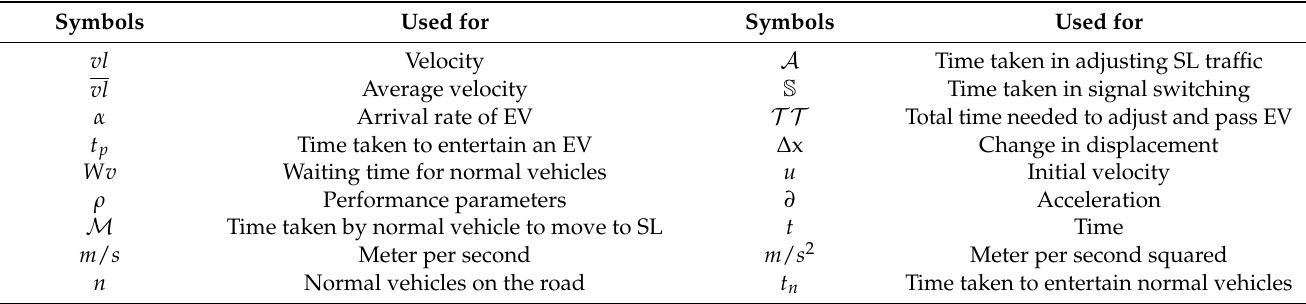
Table 3. Symbols and notations